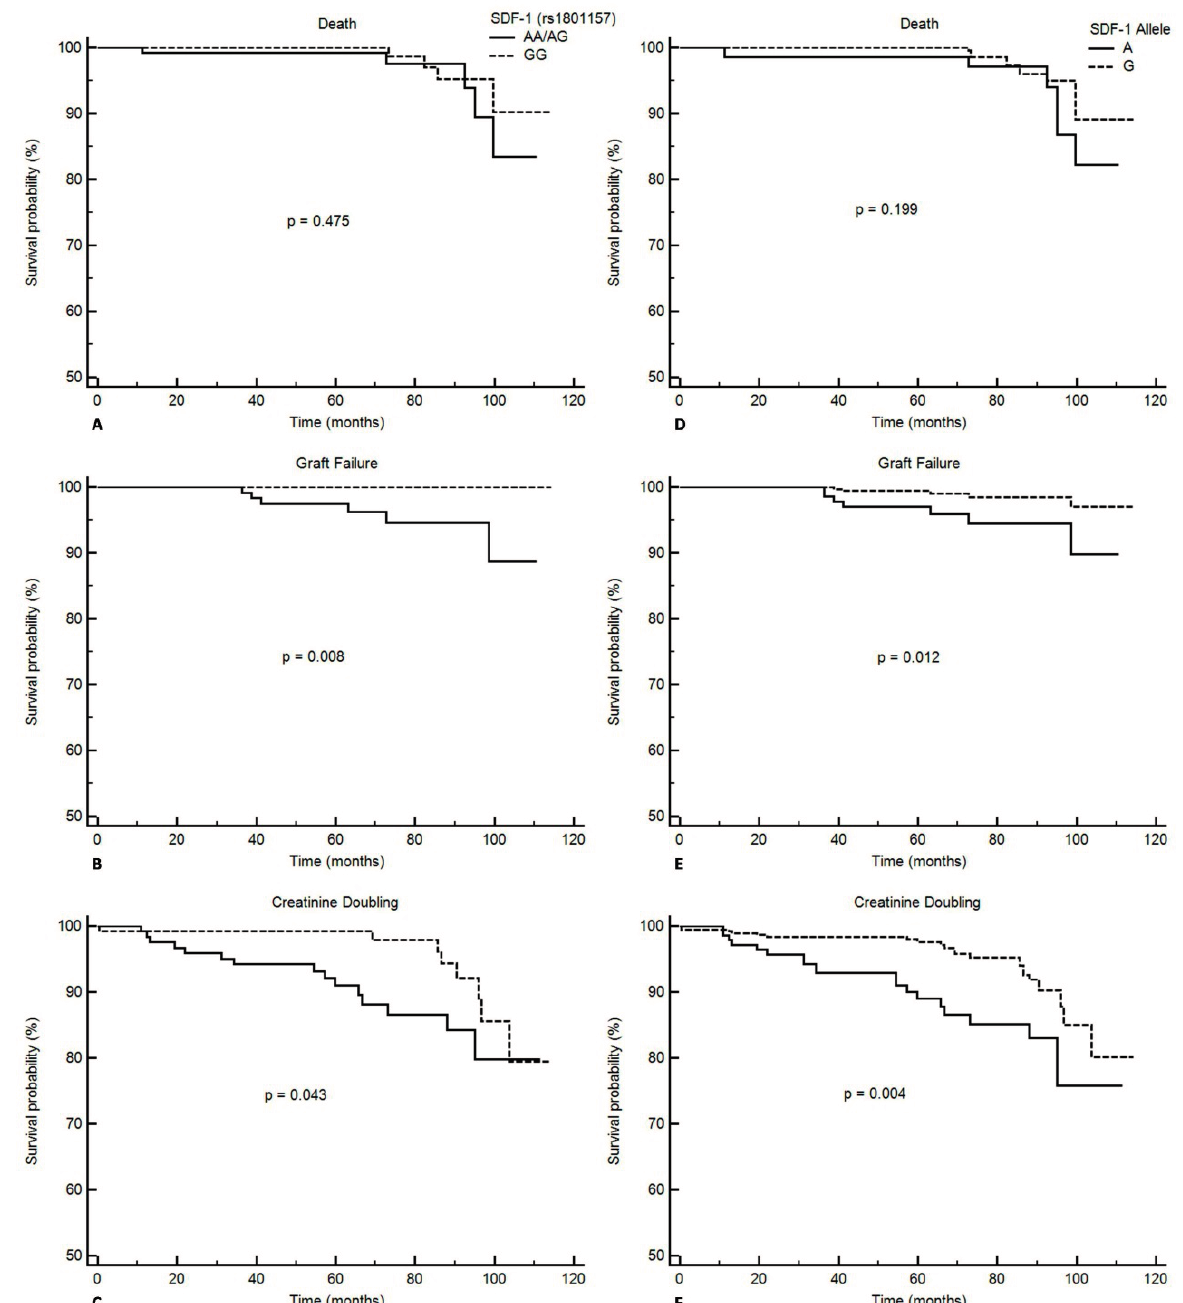
Figure 3. Kaplan-Meier curve and log-rank test comparing the cumulative event-free probability of time to individual adverse outcome, including death ( A , D ); graft failure ( B , E ); and creatinine doubling ( C , F ) between patients with SDF-1 genotype AA/AG or GG and those with the SDF-1 allele A or